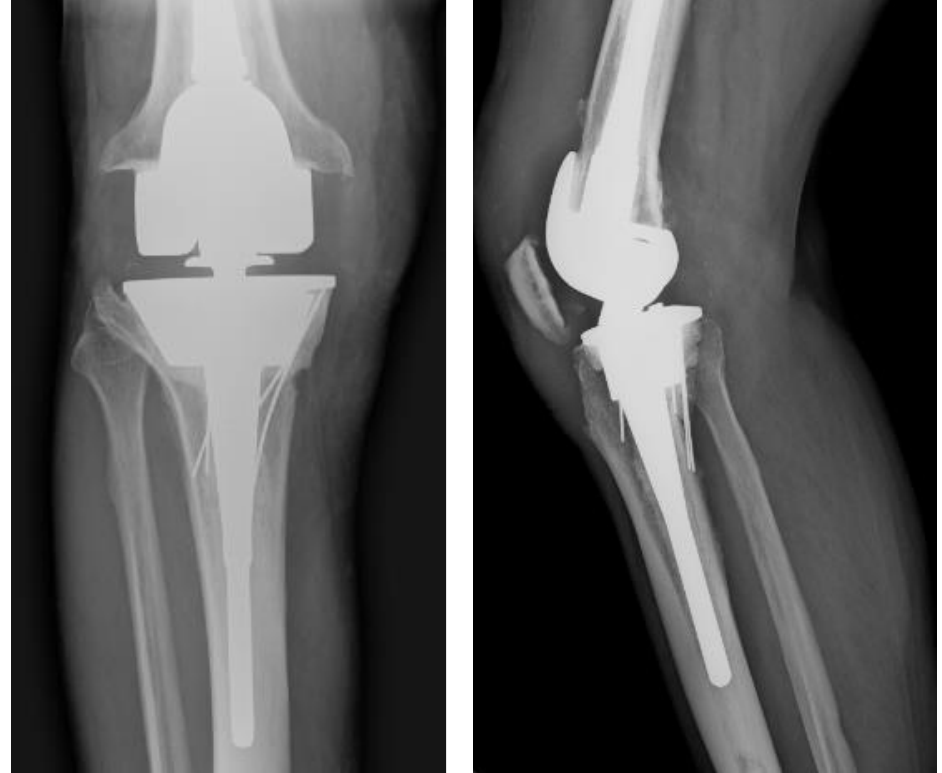
Figure 5. Two year post operative AP and lateral X-rays.